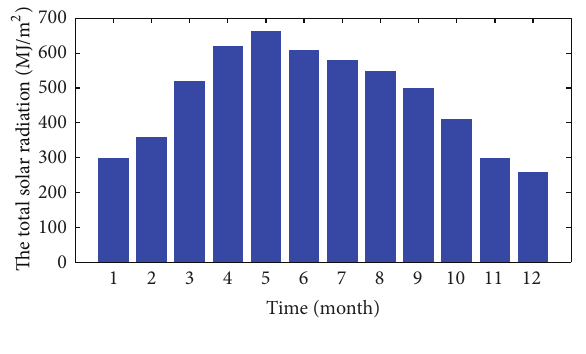
Figure 6: The annual radiation data. Table 1: Parameters of each component. Components Parameters